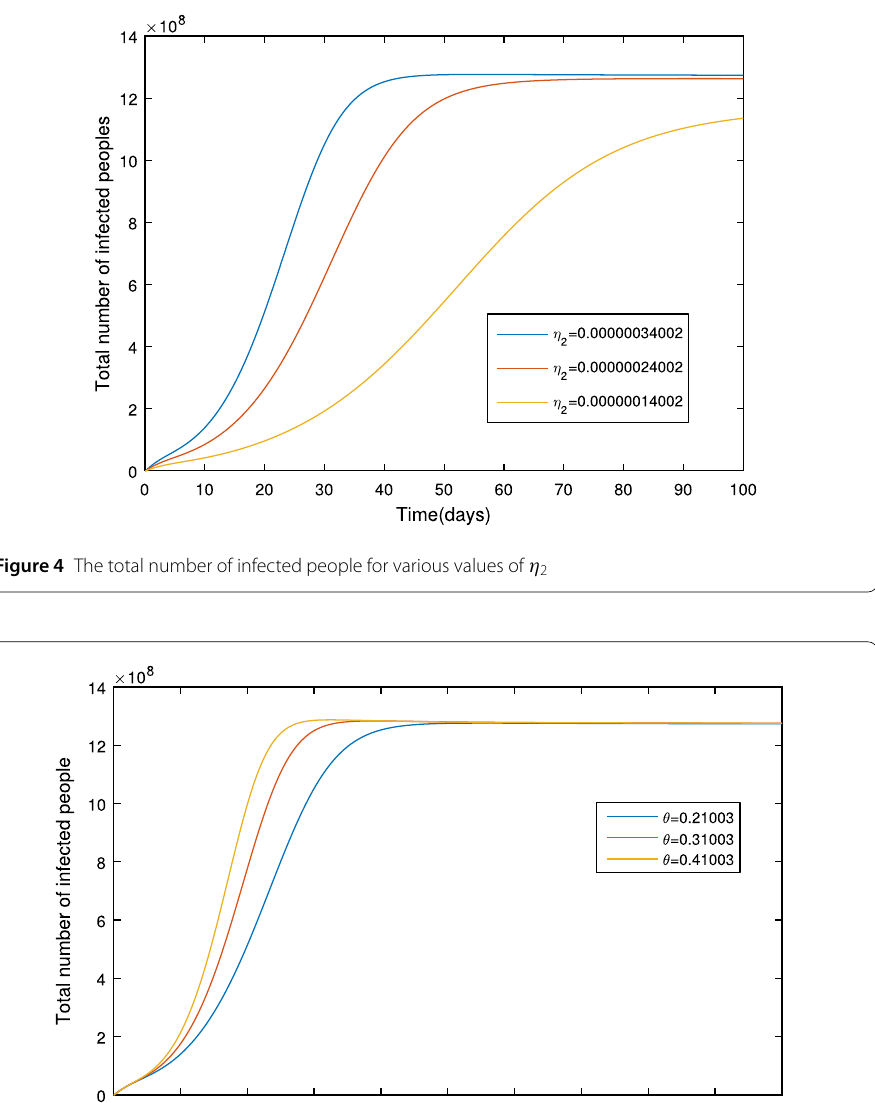
infection further. The proportion of asymptomatic infection parameter θ is shown graph- ically in Fig. 5. By decreasing the value of θ , the total number of infected people is de- creasing. Therefore, the asymptomatic infection plays an important role in the infection generation, and therefore, the people should be educated to avoid the interaction with such people. Similarly, the effect of parameters ρ , δ 1 , and q 3 are shown in Figs. 6–8. Also, by decreasing the values of these parameters, the total number of infected people is decreas- ing. Therefore, the quarantine class is important in the modeling of novel coronavirus. In Figs. 9 to 14, we present the dynamics of the model variables for fractal and fractional order parameter values. In Figs. 9 and 10, we choose α 2 = 1 and α 1 = 1,0.96,0.92,0.88. In Figs. 11 and 12, we choose α 1 = 1 and α 2 = 1,0.96,0.92,0.88. In Figs. 13 and 14, we